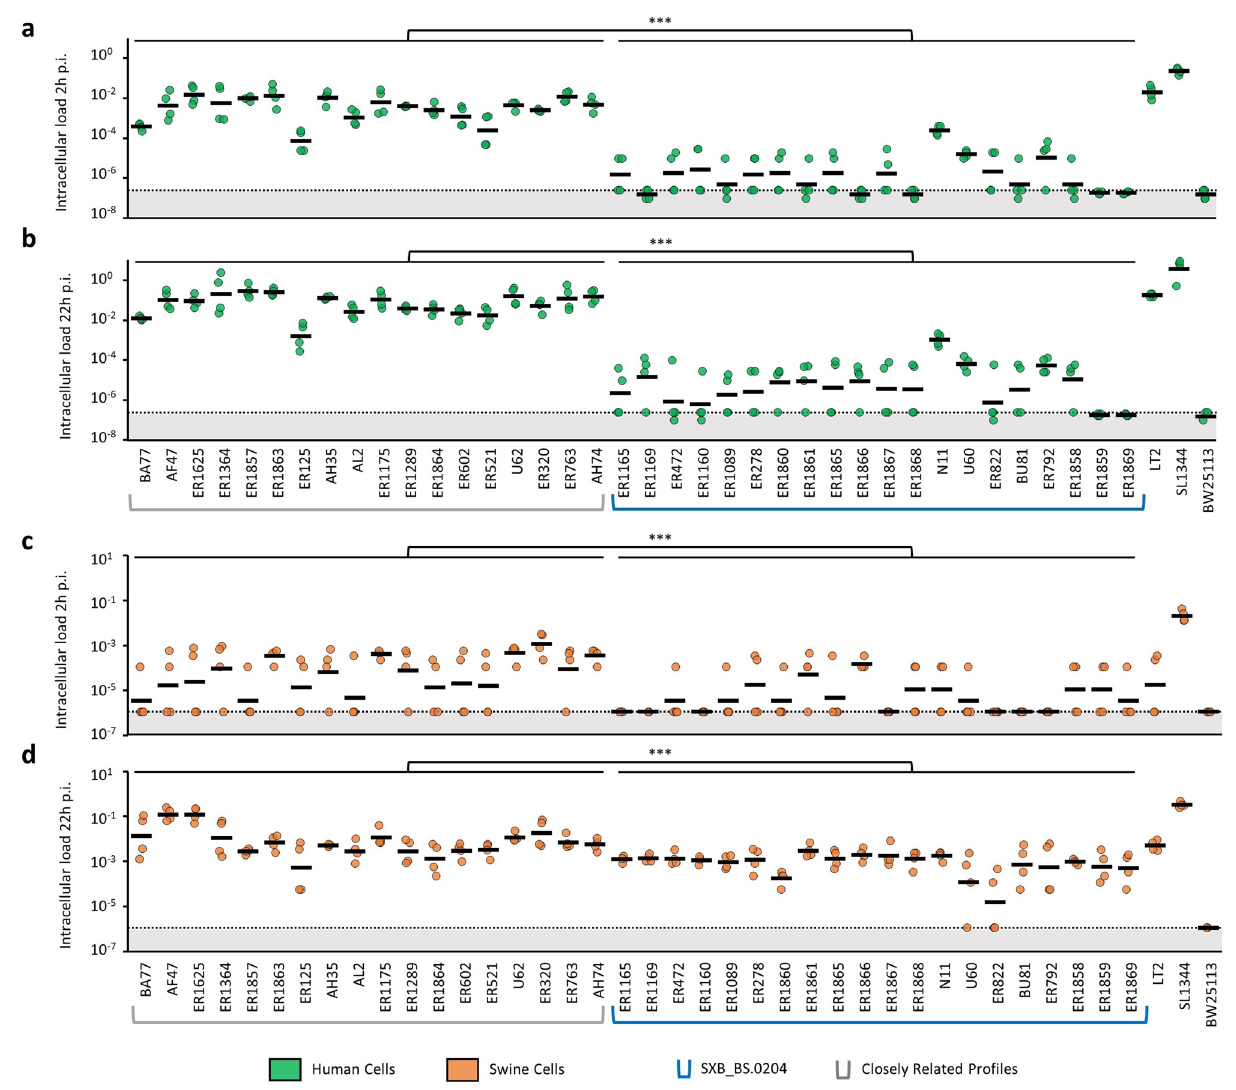
Figure 1. Virulence phenotype of S . Derby in human and swine cells. Results of intracellular loads at 2 h and 22 h post infection (p.i.) of S . Derby SXB_BS.0204 and closely related PFGE types in human cells ( a , b ) and swine cells ( c , d ). Results are expressed as intracellular bacteria recovered after 2 h and 22 h of infection divided by the inoculum. Two biological replicates were performed and each one was tested in duplicate. Dots represent the values of the replicates. Arithmetic means are indicated by horizontal lines. p-values from two-tailed Student’s t-test are reported (***p < 0.001). The dotted line corresponds to the limit of